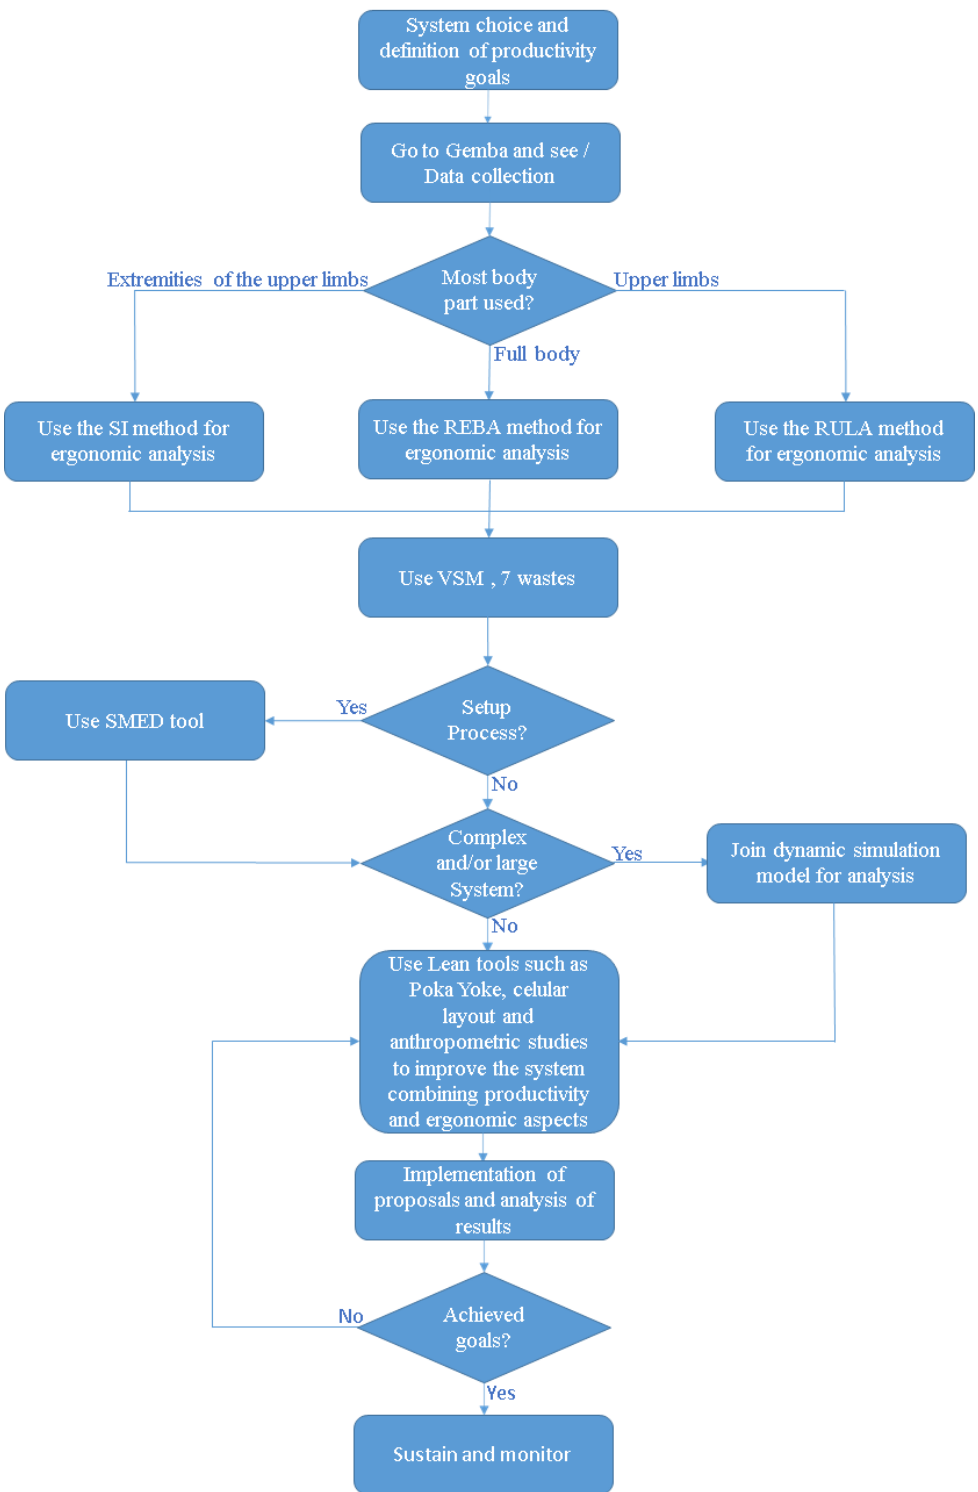
Figure 1 . Methodology